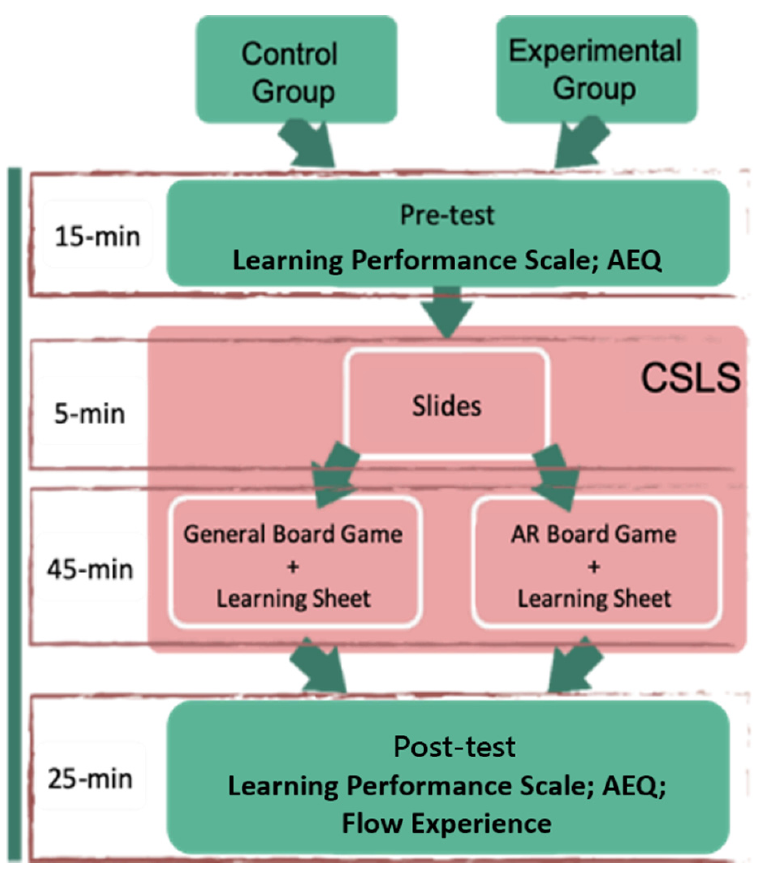
Figure 2. The research process flowchart.